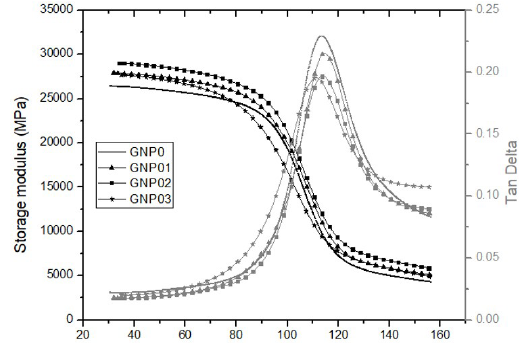
Figure 1. Storage modulus (E’) and tan delta curves by DMA analysis.